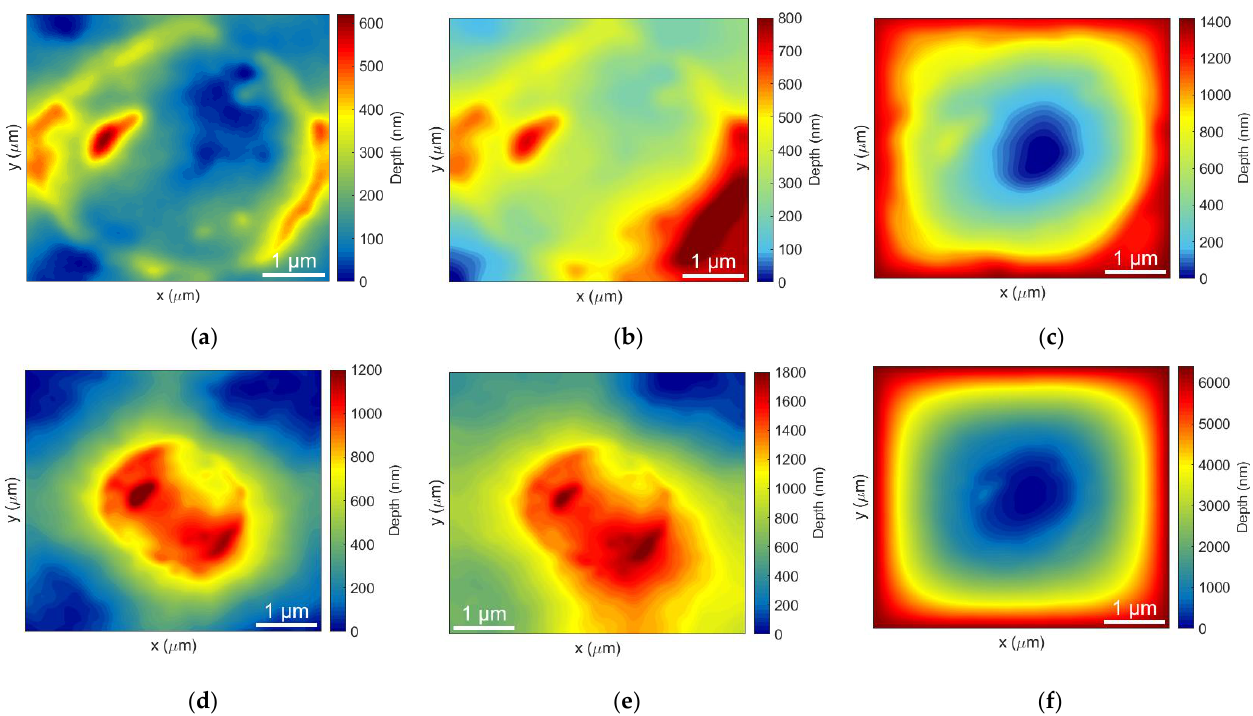
Figure 4. 2D crater images retrieved using TIE for different conditions: ( a , d ) no boundary conditions; ( b , e ) Neumann boundary conditions; ( c , f ) Dirichlet boundary conditions.